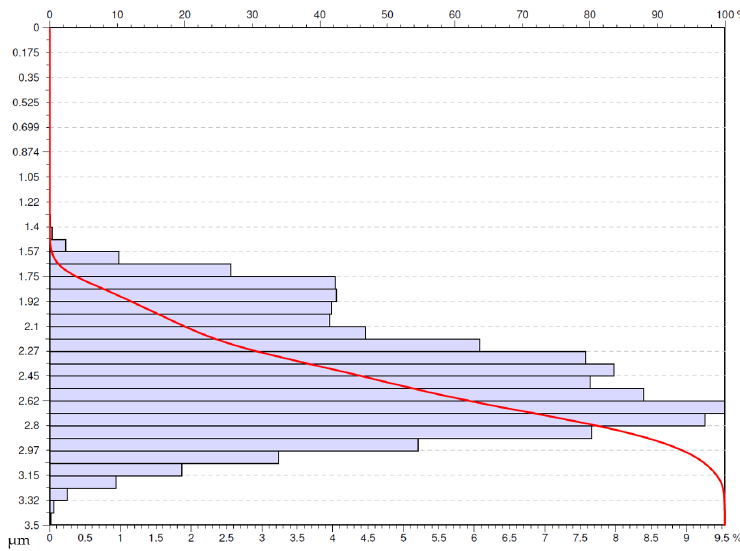
Figure 22. Abbott-Firestone curve after wet turning by conventional insert with feed f = 0.05 mm/rev.